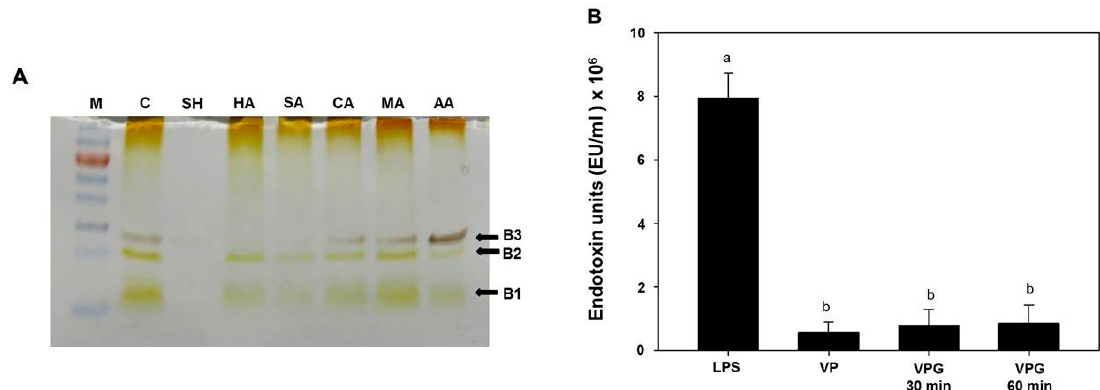
Figure 2. ( A ) Silver stained SDS-PAGE gel showing banding patterns of lipopolysaccharides (LPS) extracted from different chemical-treated VPGs. Lanes M (molecular weight marker), C (untreated V . parahaemolyticus cells), SH (sodium hydroxide), HA (hydrochloric acid), SA (sulfuric acid), CA (citric acid), MA (maleic acid), and AA (acetic acid). The amounts of LPS were loaded were 5 μ L for each lane; ( B ) Endotoxic activity of the LPS (5 µ g/mL) from Escherichia coli , V. parahaemolyticus wild-type cells (VP), VPGs treated with NaOH for 30 and 60 min. The endotoxic activity was compared using the LAL assay. The LPS of E . coli 011:B4 was used as a standard and results are given in endotoxic units (EU). All data are expressed as the mean ± the standard error of the mean. Mean separation by Duncan’s multiple range test at p < 0.05. The same letter above bars represents no significant difference between treatments.